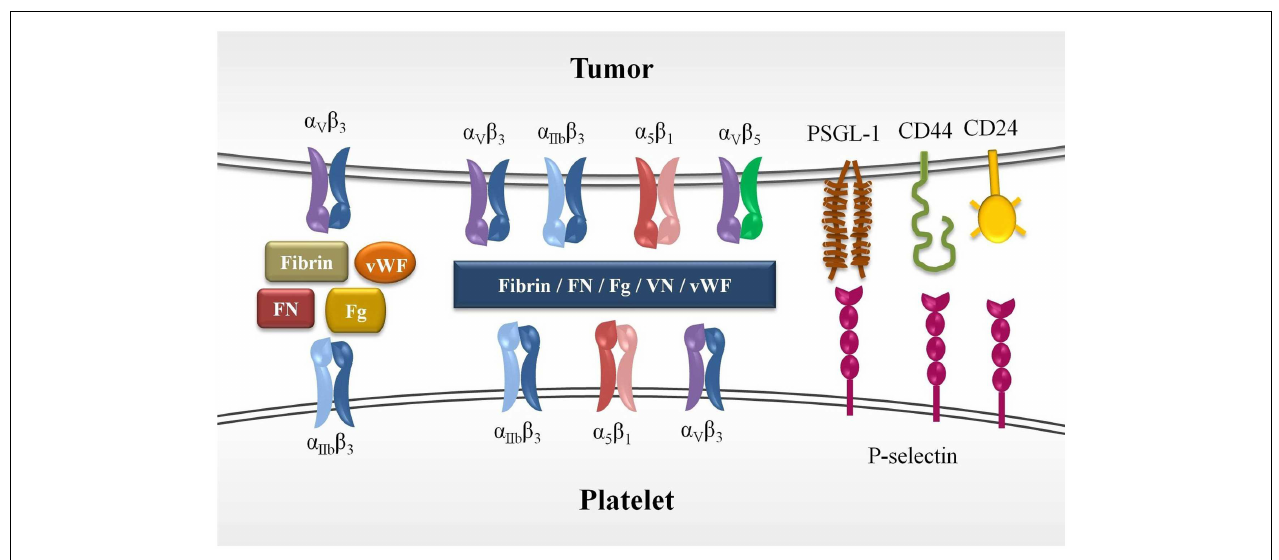
megakaryocytic genes in various tumor cells leads to the expression of functional α IIb β 3 , and therefore, the heterotypic interaction between platelets and tumor cells may take place through cross-linking of this integrin. Other integrins has also been suggested to participate in platelet–tumor aggregates formation. FN, fibronectin; Fg, fibrinogen; vWF, vonWillebrand factor;VN,